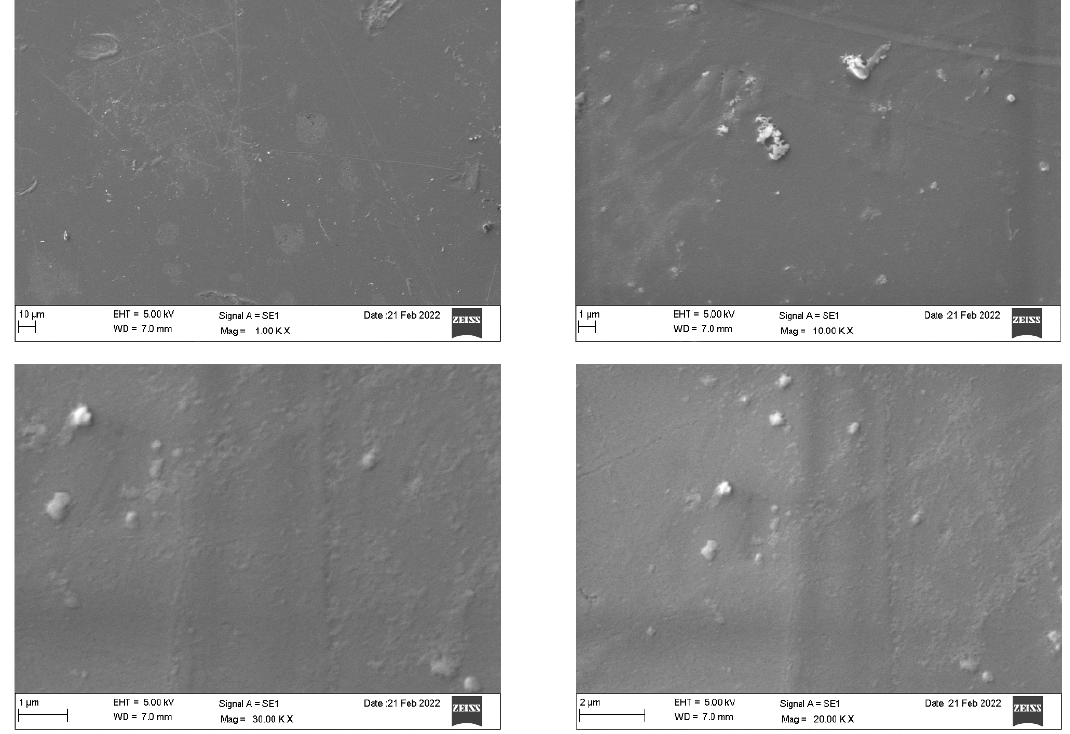
Figure 4. Scanning electron microscopy of the Eon ® system.